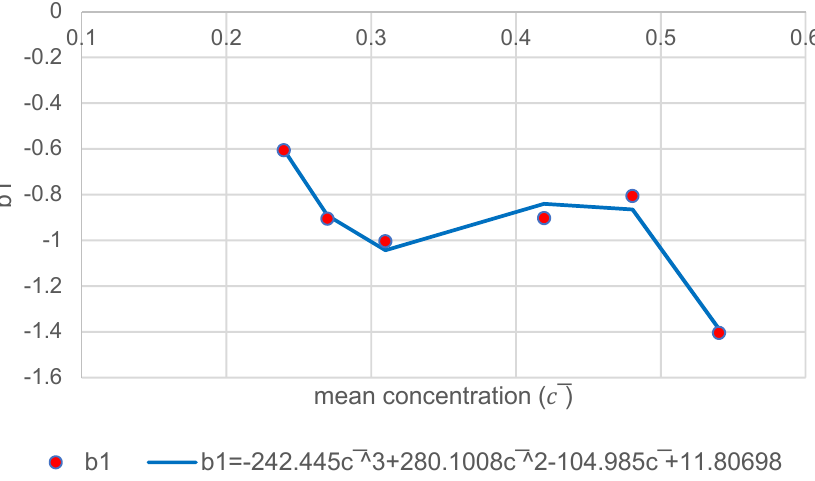
Figure 13. Mean concentration regression vs. coefficient b 1 using decision trees ( R 2 = 0.973).